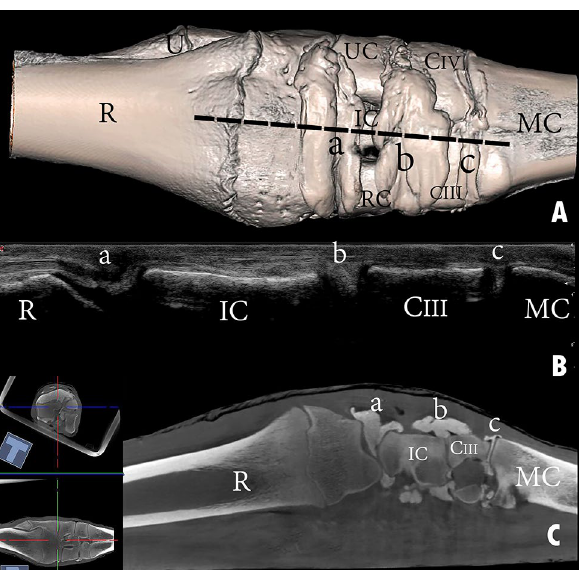
Figure 10. Dorsal view of a left carpal joint showing ( A ) three-dimensional reconstruction of the carpal joint (the black dotted line indicates the dorsal placement of the ultrasound probe); ( B ) longitudinal composed ultrasound image of the carpal joint; ( C ) sagittal plane computerized tomography image. R, the distal end of the radius; U, the distal end of the ulna; RC, radiocarpal bone; IC, intermediate carpal bone; UC, ulna carpal bone; CIII, carpal bone III; CIV, carpal bone IV; MC, metacarpal bone; a, radiocarpal joint cavity; b, intercarpal joint cavity; c, carpometacarpal joint